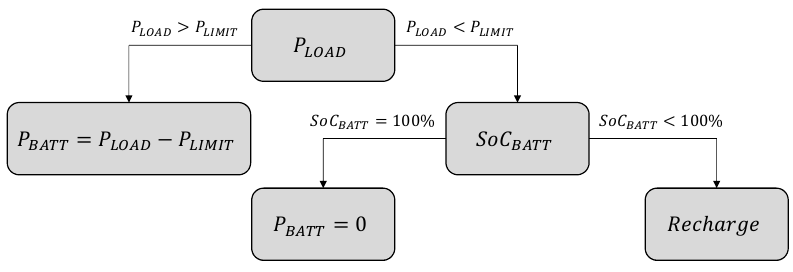
Figure 4. Flow diagram for the VSC high-level control.